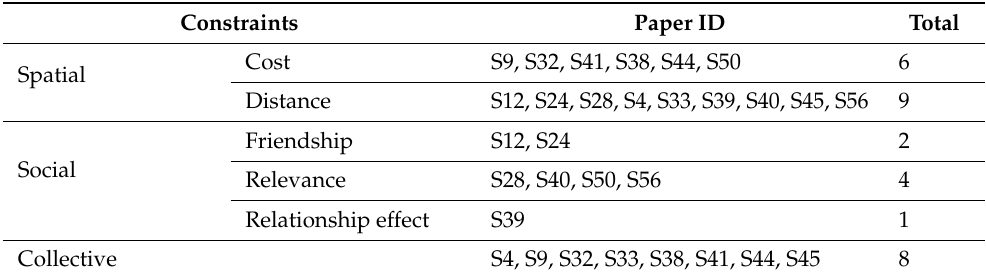
Table 9. Main types of spatial, social, and collective constraints applied in geosocial keyword